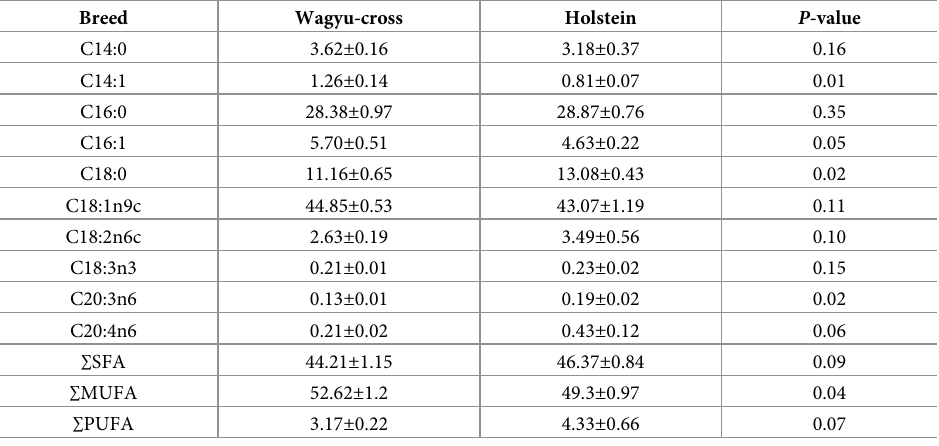
Table 4. Fatty acid composition (% of total fatty acids) of LM in Wagyu-cross and Holstein steers. Breed Wagyu-cross